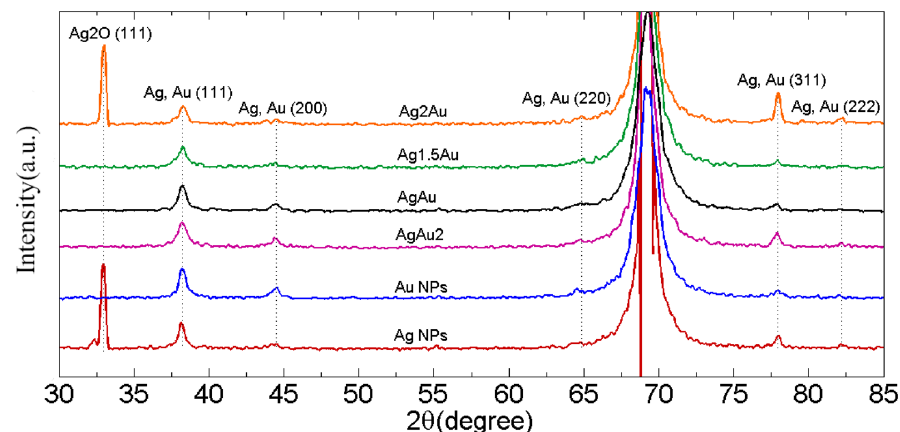
Fig. 3 X-ray diffraction pattern of Au and AgNPs beside syn- thesized Ag/Au BNPs